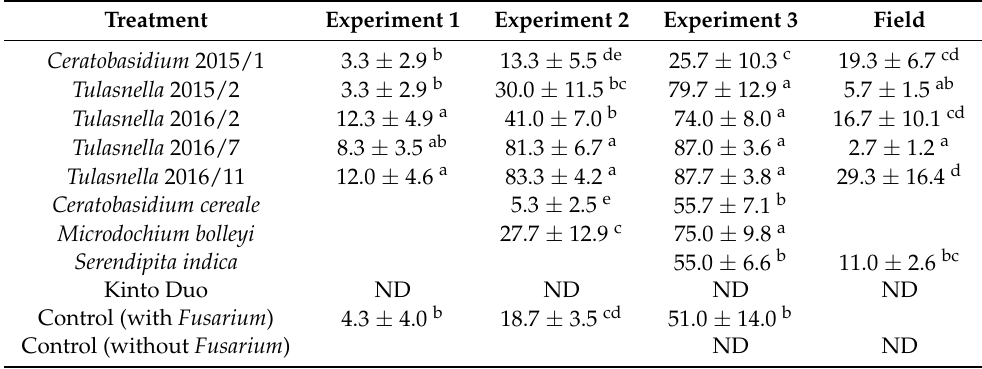
Figure 3. Endophytic fungi in wheat roots one month after inoculation. Ceratobasidium sp. 2015/1 ( a ) mostly grows extra-radically, only with few hyphae penetrating the epidermis. Tulasnella sp. 2016/7 ( b ) and Tulasnella 2016/11 ( c ) form monilioid cells inside plant cortical or epidermal tissue. Stained with trypan blue in lactoglycerol. The bars represent 100 µ m. m—monilioid cells, h—hyphae. Table 3. Percentage of wheat root colonization in all pot experiments and barley root colonization in field conditions, after inoculation with varia fungi isolates (Figure 3). Data are expressed as means ± SD ( n = 3) followed by the same letter (within the column) if there was no statistical difference according to LSD 0.05 test. ND—not